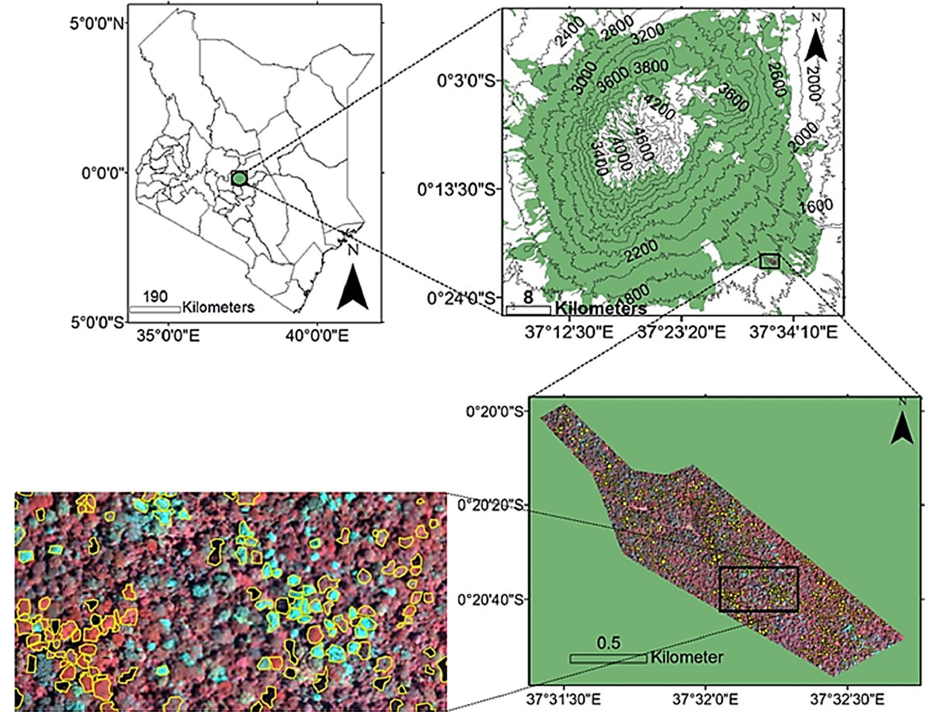
Figure 1. WorldView ‐ 2 false ‐ color composite (near ‐ infrared 2: yellow: coastal) of the study area showing tree crowns iden ‐ Figure 1. WorldView-2 false-color composite (near-infrared 2: yellow: coastal) of the study area tified to the species level and other forest landscape features in the field. showing tree crowns identified to the species level and other forest landscape features in the Mount Kenya’s abrupt changes in altitude within short distances result in a variety of plant species in a quite small area [21]. MKFR’s highly heterogeneous canopy consists of deciduous and evergreen tree species. Anthropogenic activities determine vegetation types and their distribution at the lower altitudes [21,29]. The montane forest zone lies between 1980 and 3000 m asl on the western, eastern, and southern sides of the mountain [30]. The northern side is covered by grass, scattered trees, and Ericaceae and Protea scrub [30]. Nyayo Tea Zone, established by Legal Notice No. 265 of 1986 provides a buffer zone to check against human encroachment into MKFR.